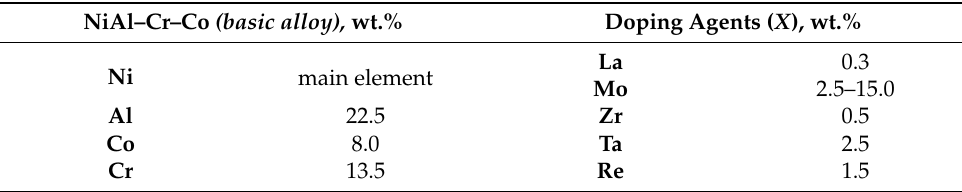
Table 2. The calculated composition of the alloy and the content of doping